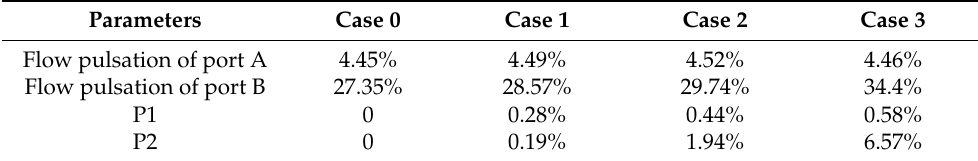
Table 3. Numerical result analysis table.